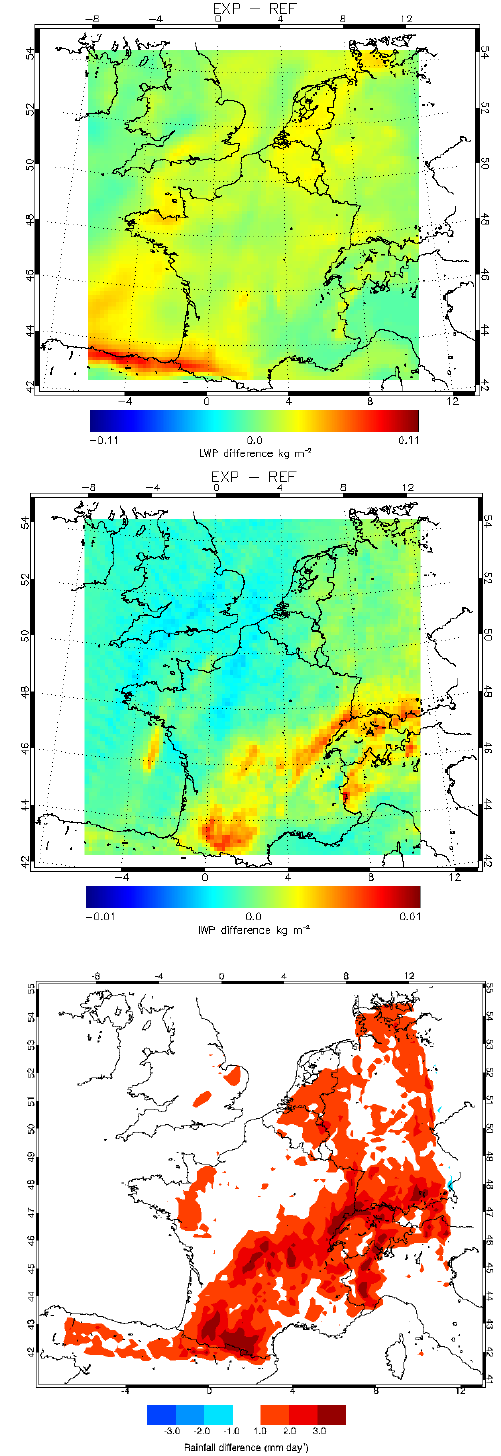
Figure 7: Monthly mean differences in liquid water path (upper panel), ice water path (middle 3 Fig. 7. Monthly mean differences in liquid water path (upper panel), panel) and rainfall amounts (lower panel) between the COT assimilation experiment and the 4 Reference simulation. 5 ice water path (middle panel) and rainfall amounts (lower panel) be- tween the COT assimilation experiment and the Reference simula-